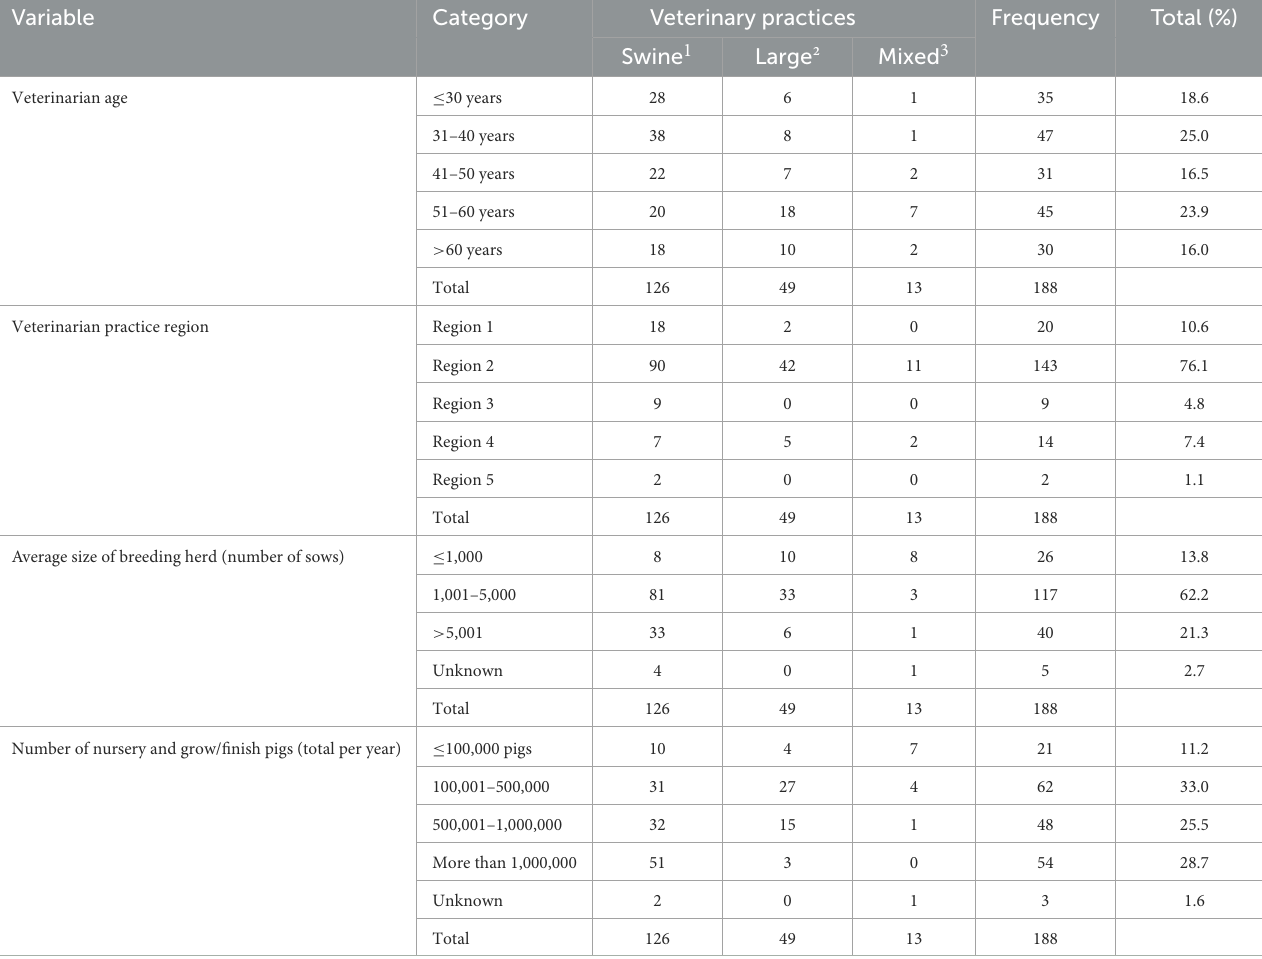
TABLE 1 Influenza A virus veterinarian survey respondent demographic characteristics and description of veterinary practice types. Variable